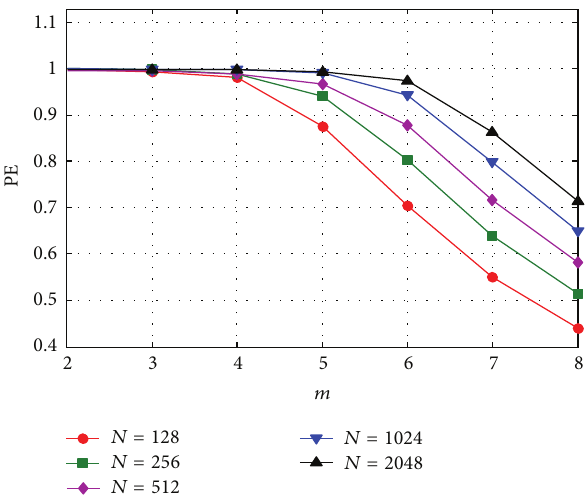
Figure 1: The PEs of white Gaussian noise signals with different lengths when 𝜆 = 1 .